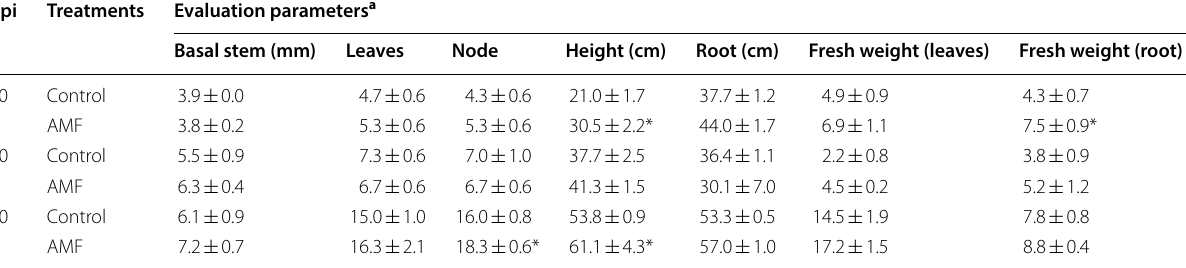
dpi: Days post inoculation; Control: P. aduncum non-inoculated with AMF; AMF: P. aduncum inoculated with AMF * Statistical difference according to Bonferroni-test ( p < 0.05)